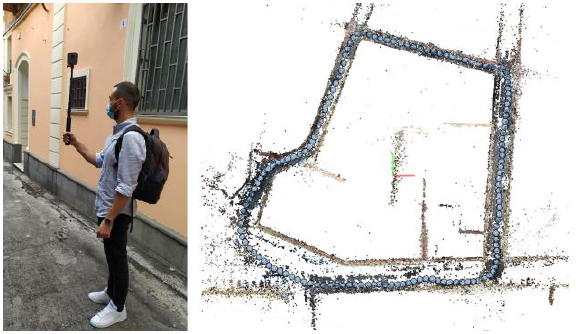
Figure 4 . On the left: GOPRO Fusion 360 on site during acquisition. On the right: sparse cloud with points of acquisition inside Metashape.